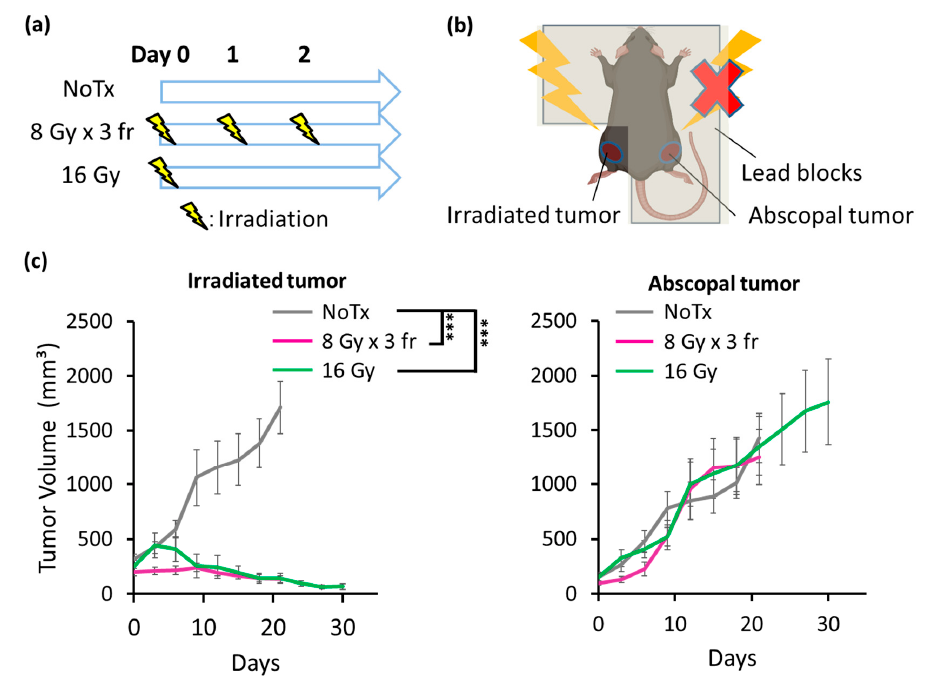
Figure 4. Tumor volume changes by radiation monotherapy. ( a ) The treatment schedule. Treatments were initiated when the longest diameter of the tumor exceeded 8 mm (day 0). ( b ) The irradiation setup. ( c ) The tumor volume changes in irradiated and abscopal tumors. Each error bar represents SE. Tukey–Kramer’s HSD test was performed to compare the differences in tumor volumes on day 18 between NoTx (N = 12), 8 Gy × 3 fr (N = 11), and 16 Gy (N = 7) groups. Tumor volume was evaluated until 70% of the mice in each group were dead. ***: p < 0.001. Abbreviations—NoTx: no treatment; fr: fraction.